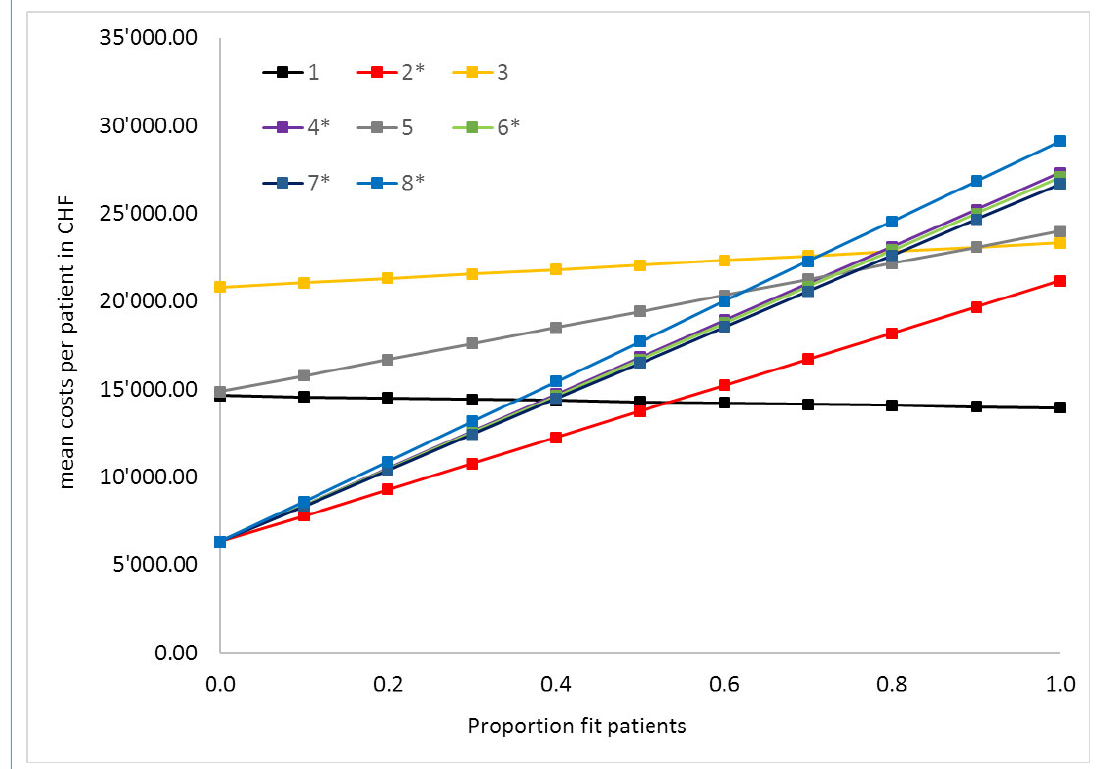
Figure 1: One-way sensitivity analysis expected base case mean costs per patient and centre by proportion of fit patients.* Centres were unfit patients receive best supportive care